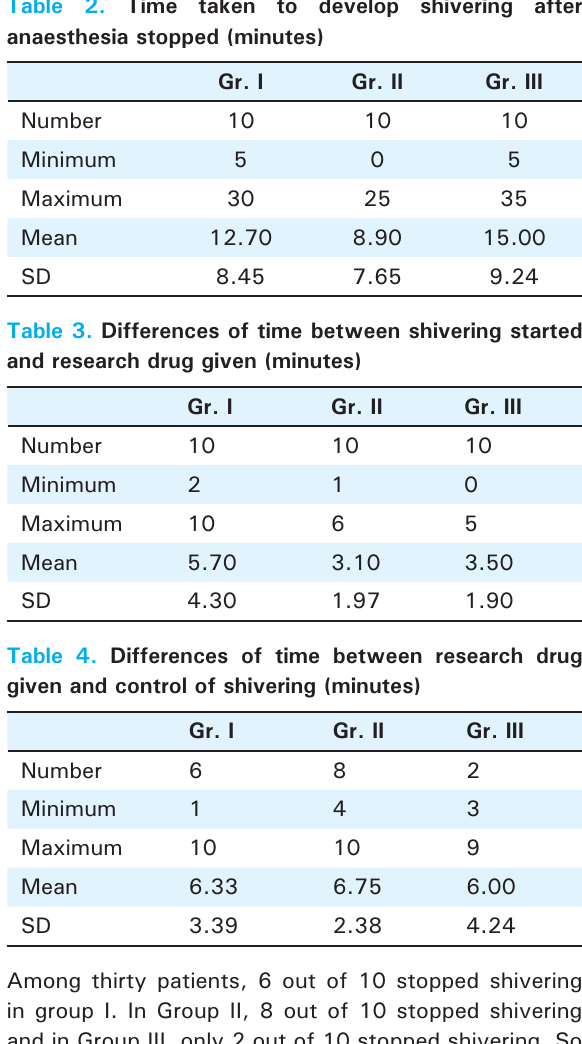
Table 2. Time taken to develop shivering after